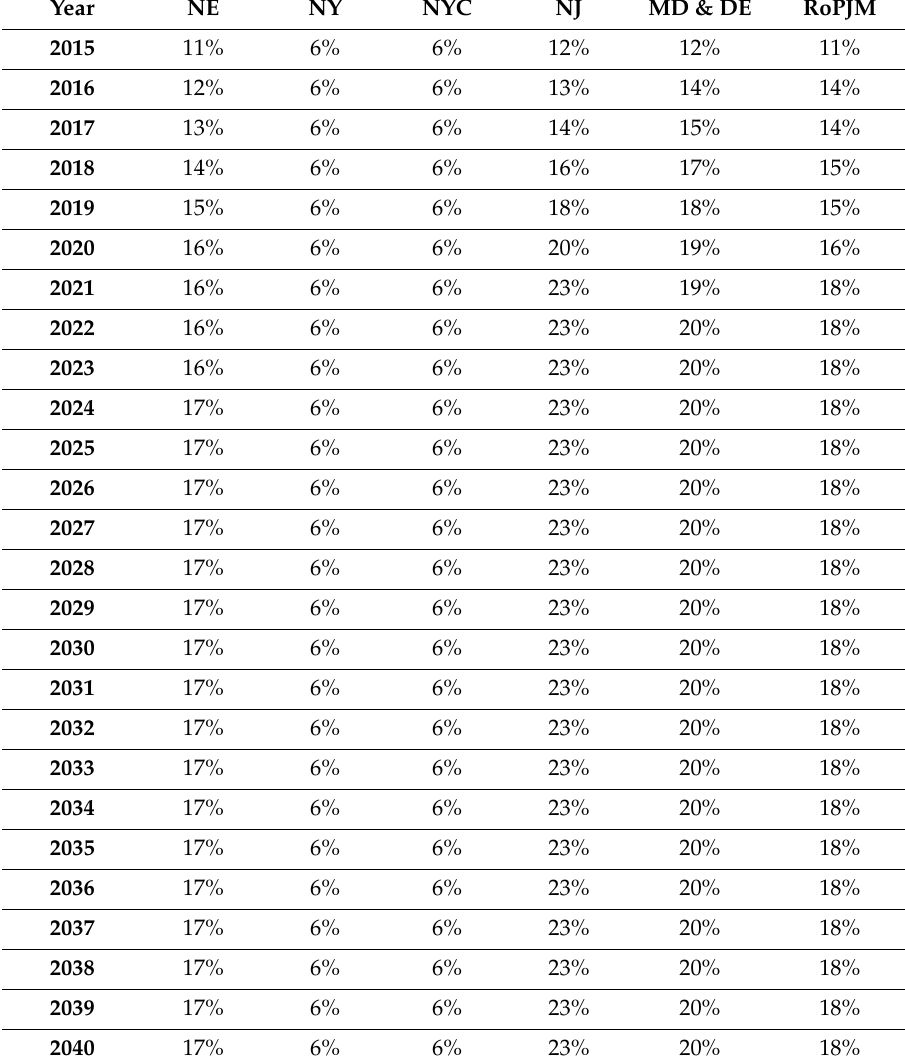
Table A12. Minimum Percentage of Total Annual Dispatch from Renewables by Region (General Electric International, 2014).